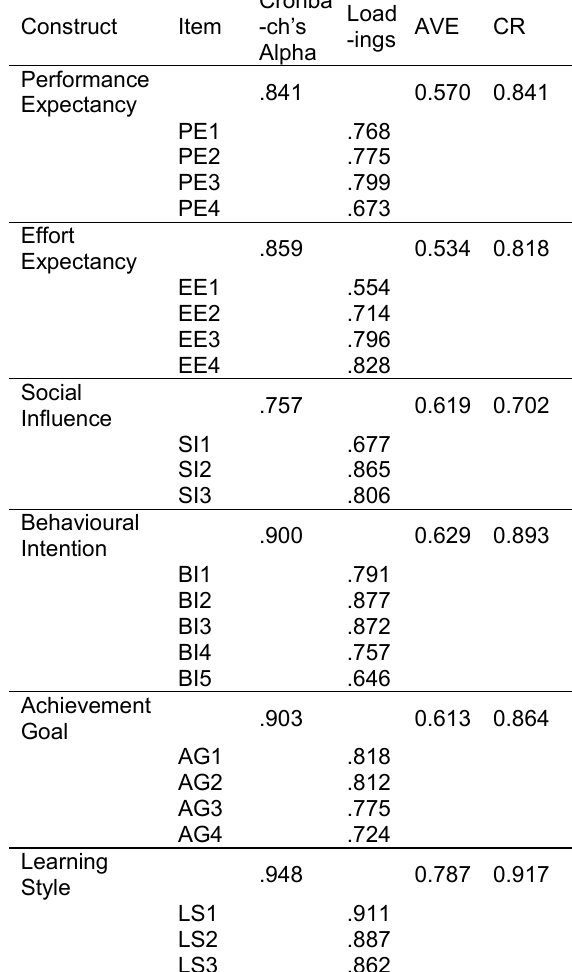
Table 1. Reliability and Validity of the Constructs